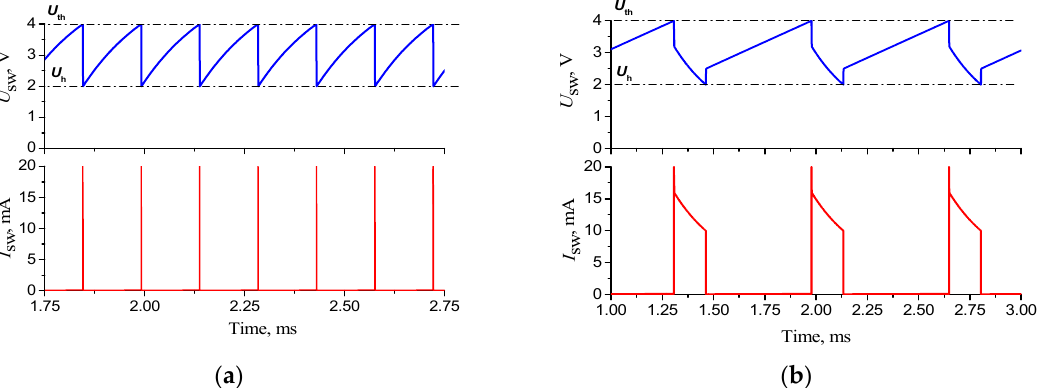
Figure 2. Voltage (current) oscillogramms of OSC1 ( a ) and OSC2 ( b ). Circuit options in Table 1 and I 0 = 0.15 mA ( a ), R = 100 Ω and I 0 = 3 mA ( b ).